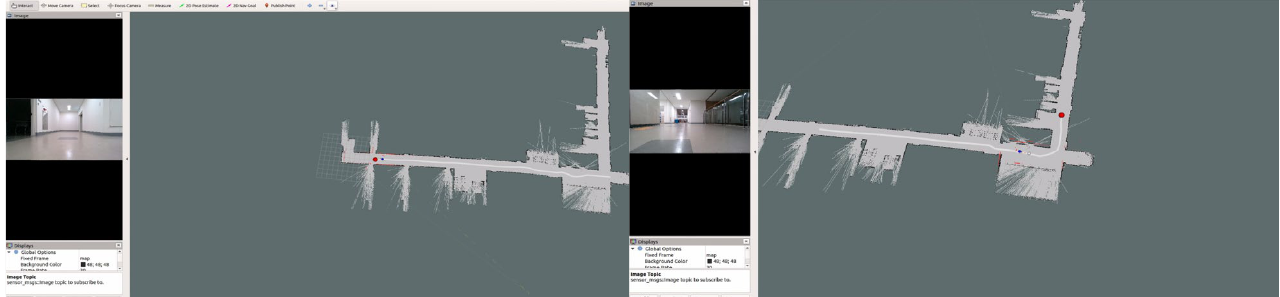
Figure 5. Path image of the experiment. Red dot is robot’s destination. Blue dot is the robot’s current estimated position. Gray area is the movable area, and light gray is the path that the robot has found.